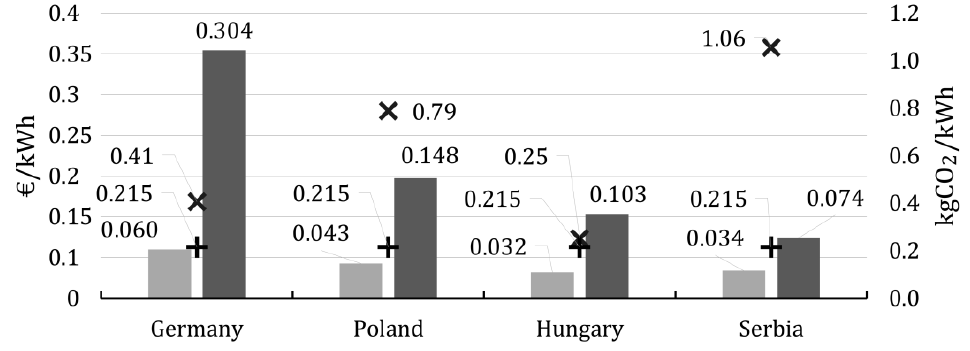
Figure 4. Prices of different types of energy (left axis) and the footprint of energy (right axis).